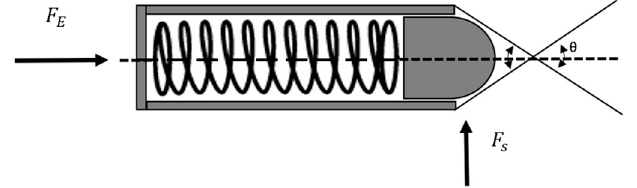
Figure 3. Diagram of the spring plunger forces.